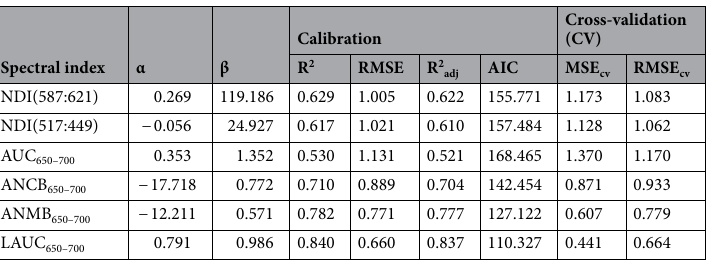
Table 1. Results of analyses using linear regressions models for estimating Chl a in sea ice based on index computation method (2) (seen in Fig. 2). α and β refer to the regression model intercept and slope found in Eq. 8. R 2 refers to the coefficient of determination, RMSE stands for Root Mean Square Error, AIC to Akaike Information